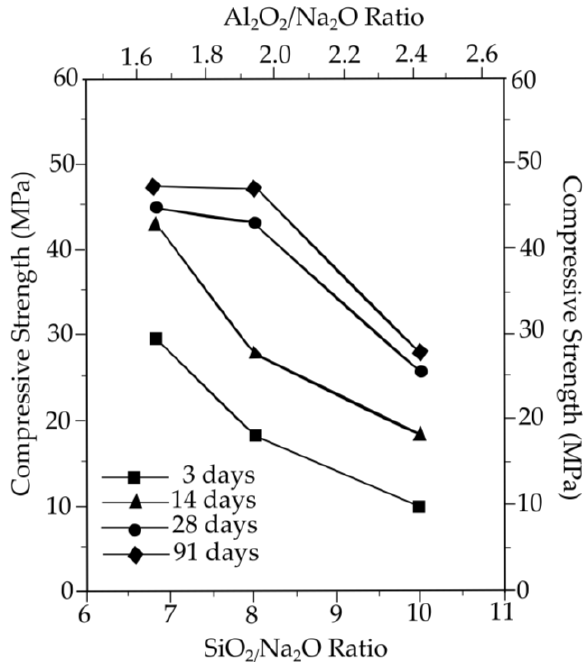
Figure 11. Compressive strength versus ages for molarity of NaOH [143].